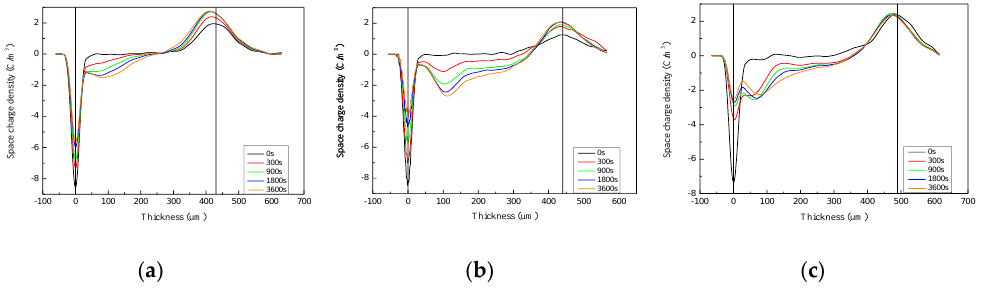
Figure 9. The charge density distribution of neat pressboard and nano-MMT/pressboard nanocomposites with different filling rates: ( a ) neat pressboard, ( b ) 1.0 wt % MMT, and ( c ) 7.5 wt % MMT.